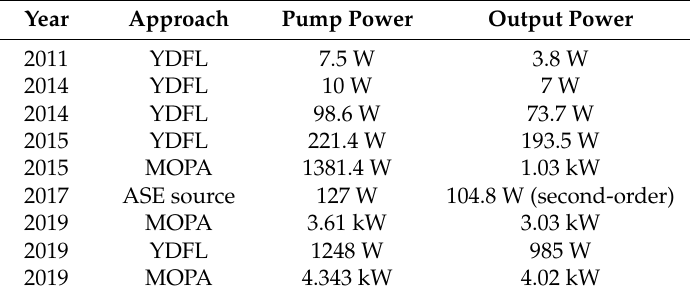
Figure 11. The setup of the RFL seed and the amplifier. BPF, bandpass filter; P4, an extra port of WDM; RDFB, random distributed feedback; HR-FBG, high-reflectivity fiber Bragg grating; LD, 976 nm laser diode; PD, photo-detector; OSC, oscilloscope. Table 1. The evolution of high power RFL.